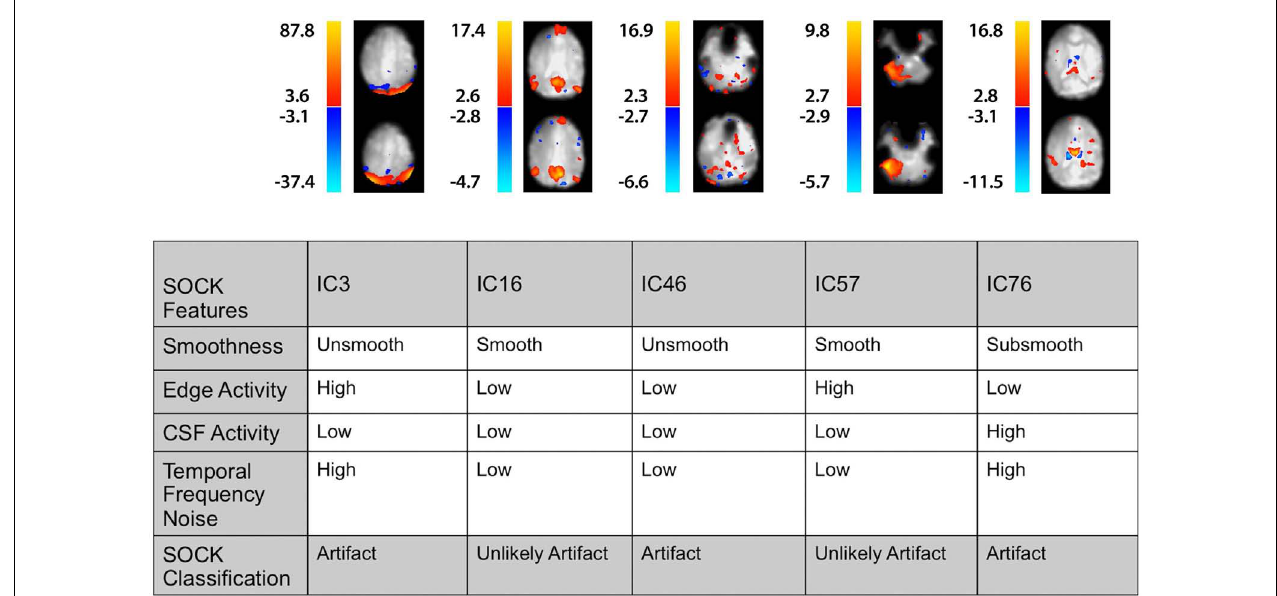
FIGURE 6 |A selected set of spatial maps from an ICA and corresponding SOCK classification for Subject 4 .The numbering of the ICs is based on the order of extraction in the ICA